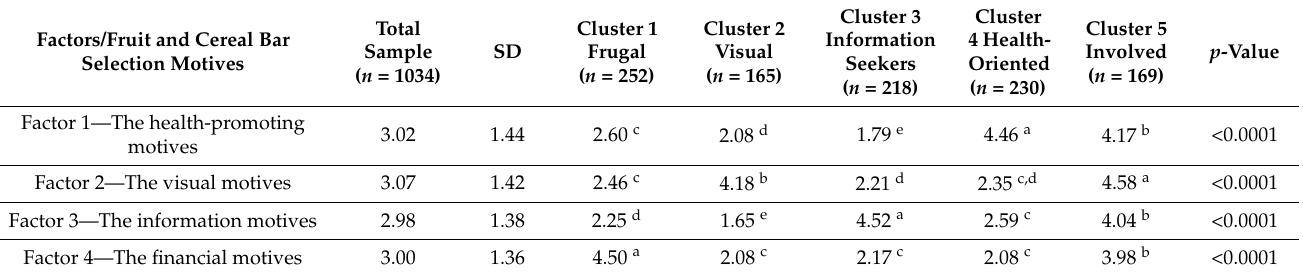
Table 3. Characteristics of the clusters identified according to the motives regarding fruit and cereal bar selection (factors), (mean; standard deviation, n = 1034,